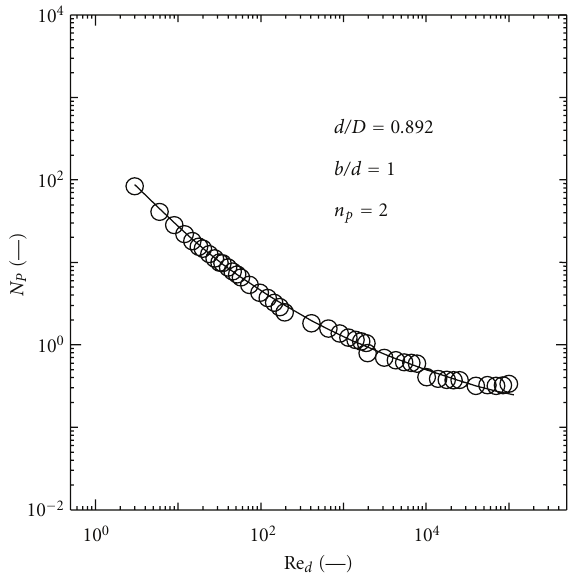
Figure 7: Power diagram of anchor impeller (— calc; (cid:2) N P 0 ).